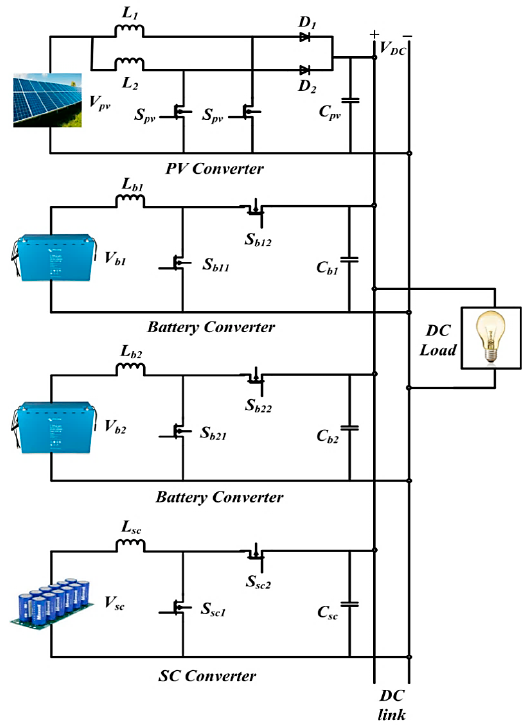
Figure 6. Proposed µG structure.